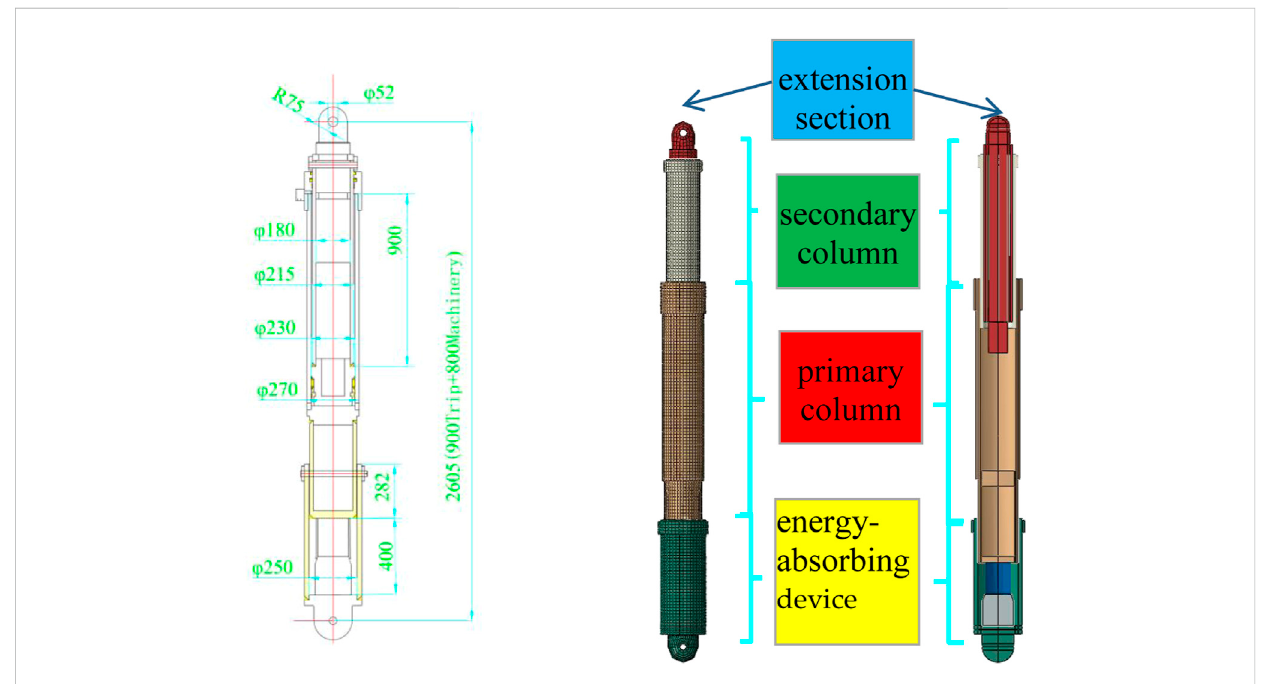
FIGURE 3 Design drawing and model of energy-absorbing and anti-scouring columns.